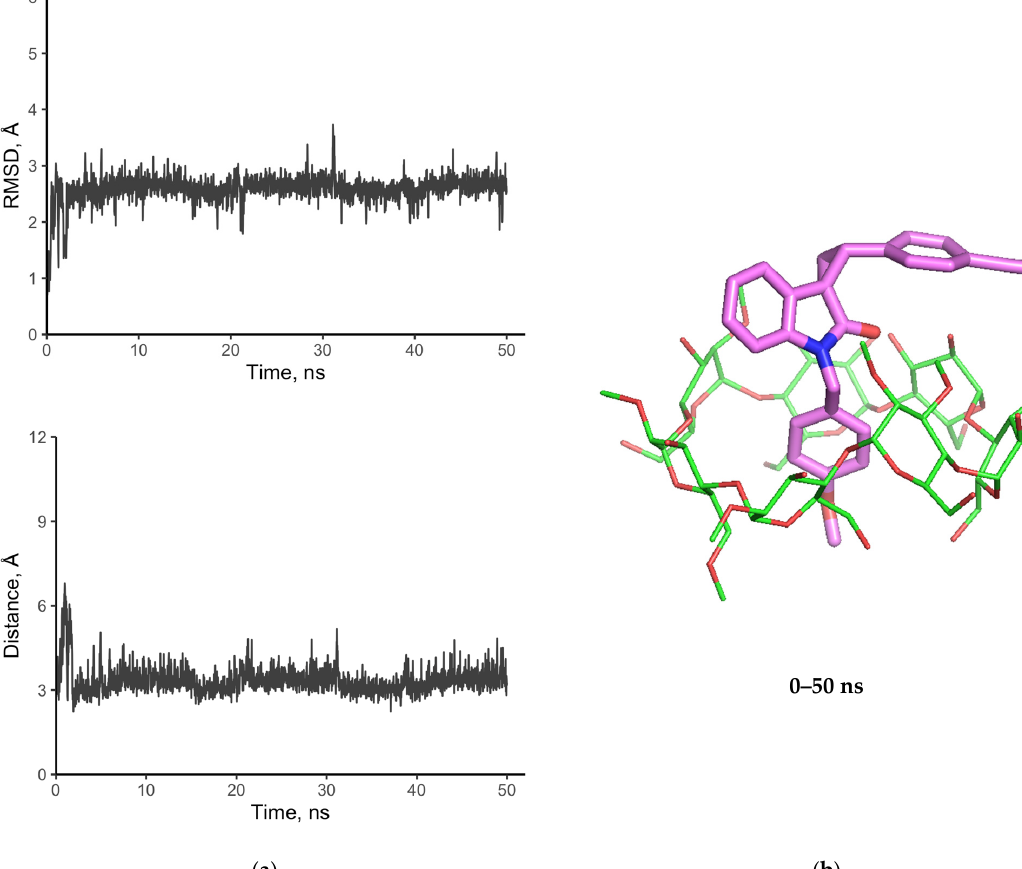
Figure 12. ( a ) Root-mean-square deviation (RMSD) and distance between the M β CD and 2b centers of geometry (Type I complex). ( b ) Type I complex structure.